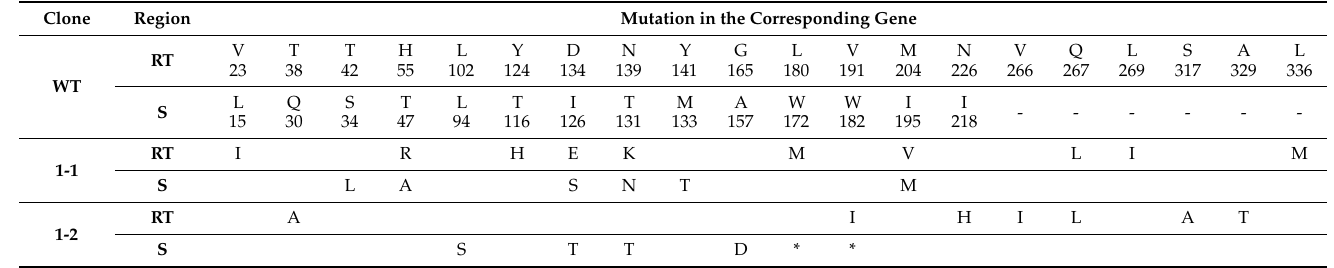
Table 3. Patient-derived common mutations in HBV RT and overlapping surface antigen. Mutation in the Corresponding Gene